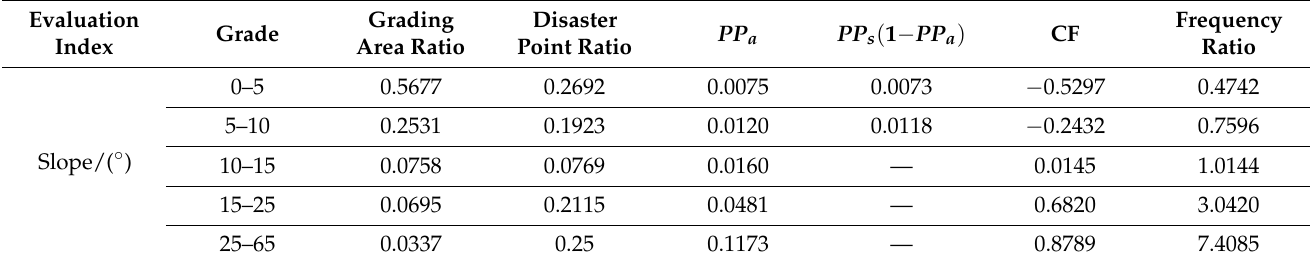
Table 3. Certainty Table 3. Certainty Factor.